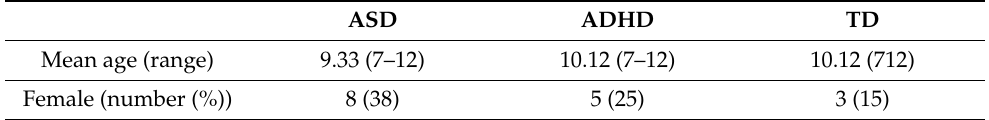
Table 1. Demographic characteristics of the included participants: 21 children with typical develop- ment (TD), 20 children with attention deficit hyperactivity disorder (ADHD), and 20 children with autism spectrum disorder (ASD). The clinical participants were 20 children with